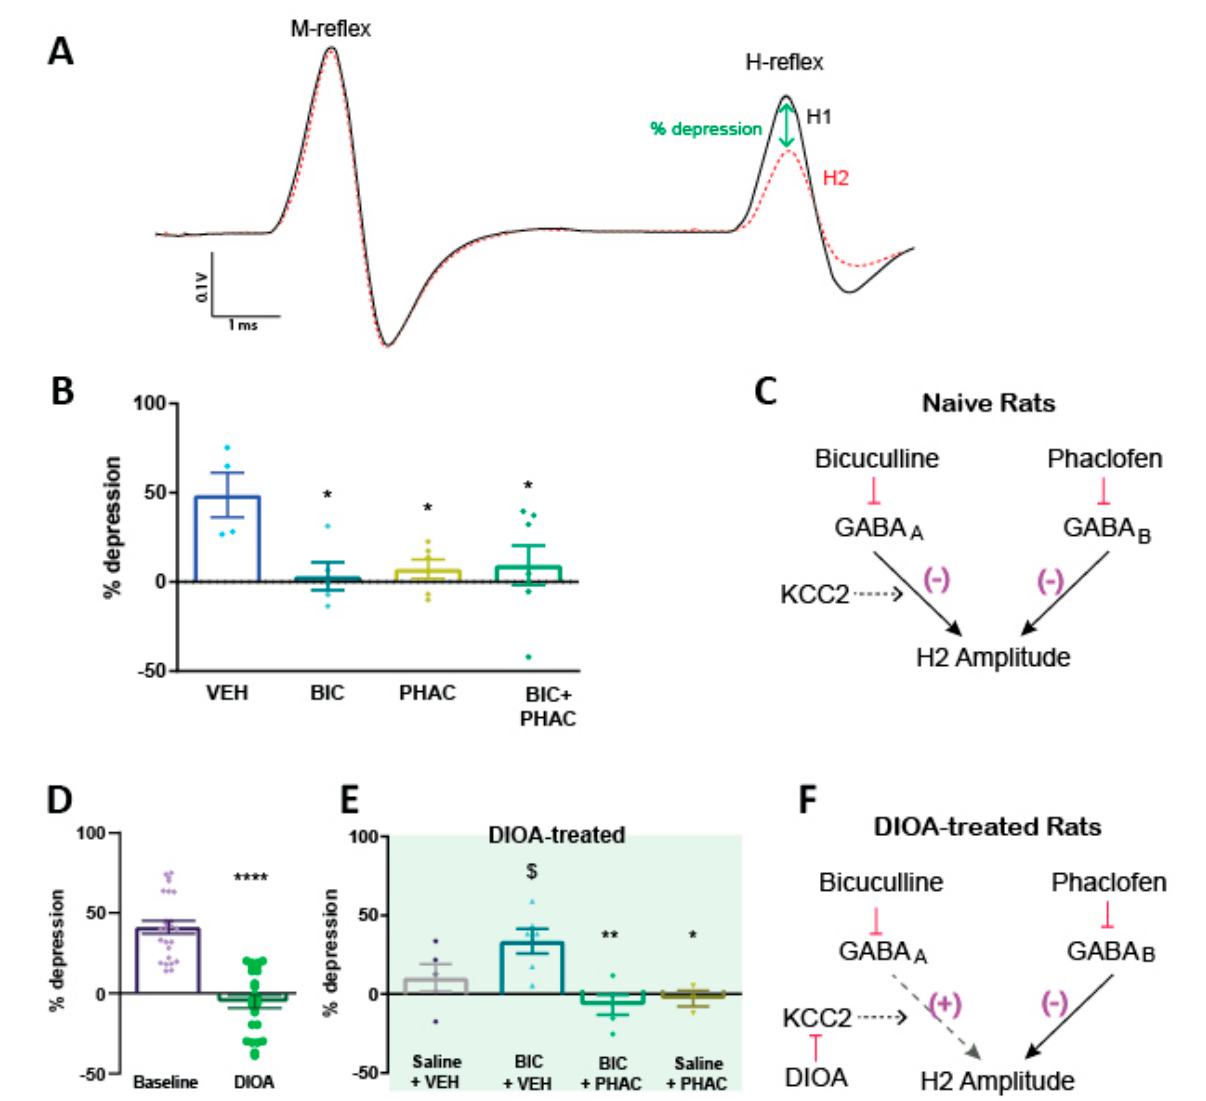
Figure 1. Pharmacology of RDD in 16-week-old female Sprague-Dawley rats. ( A ) Representative M- and H-reflex traces from naïve rats. % depression is calculated as the change in amplitude of the second recorded H-reflex (H2) compared